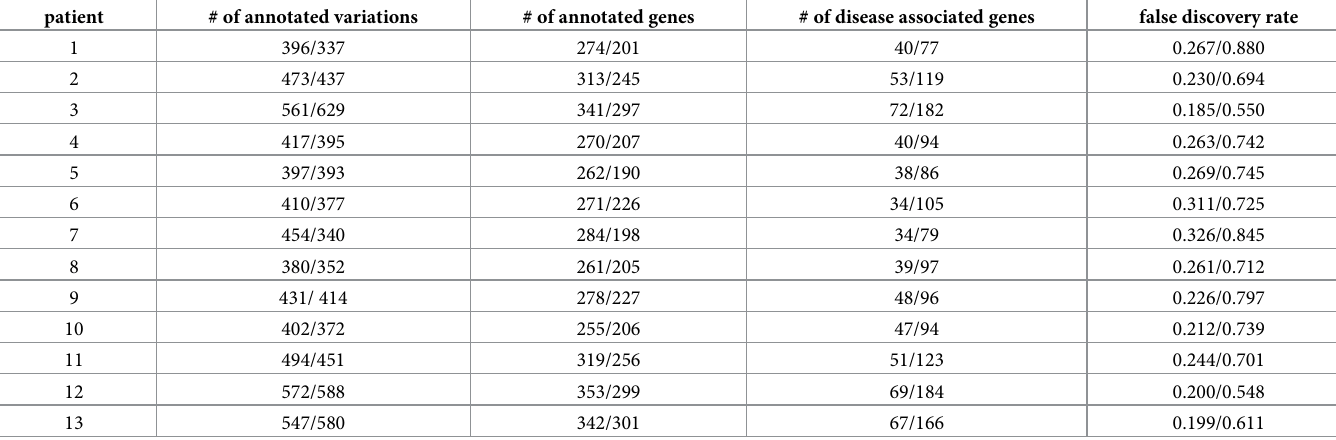
Table 5. Summary of patient annotations using ENTPRISE-X a